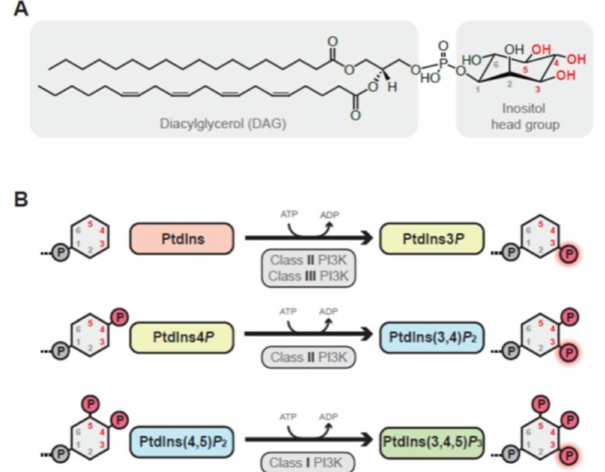
Figure 1. Chemical structure of phosphatidylinositol and phosphoinositide 3-kinase (PI3K)